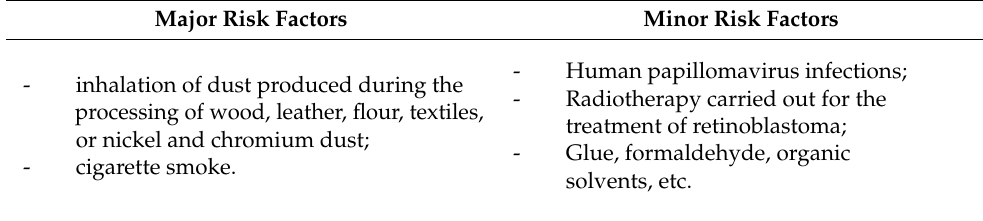
Table 1. Sinonasal carcinoma risk factors. Major Risk Factors Minor Risk Factors